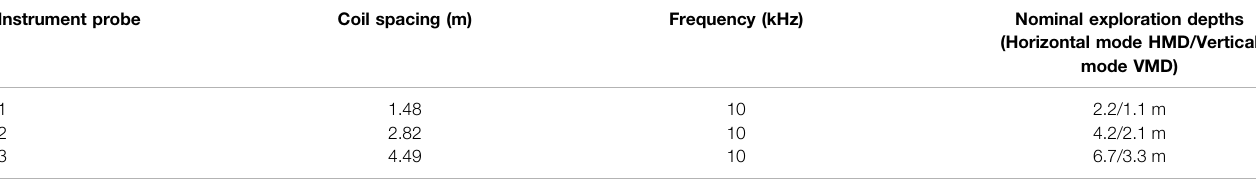
TABLE 1 | Technical speci fi cations of the multi-coil CMD Explorer FDEM (gf-instruments.cz). Instrument probe Coil spacing